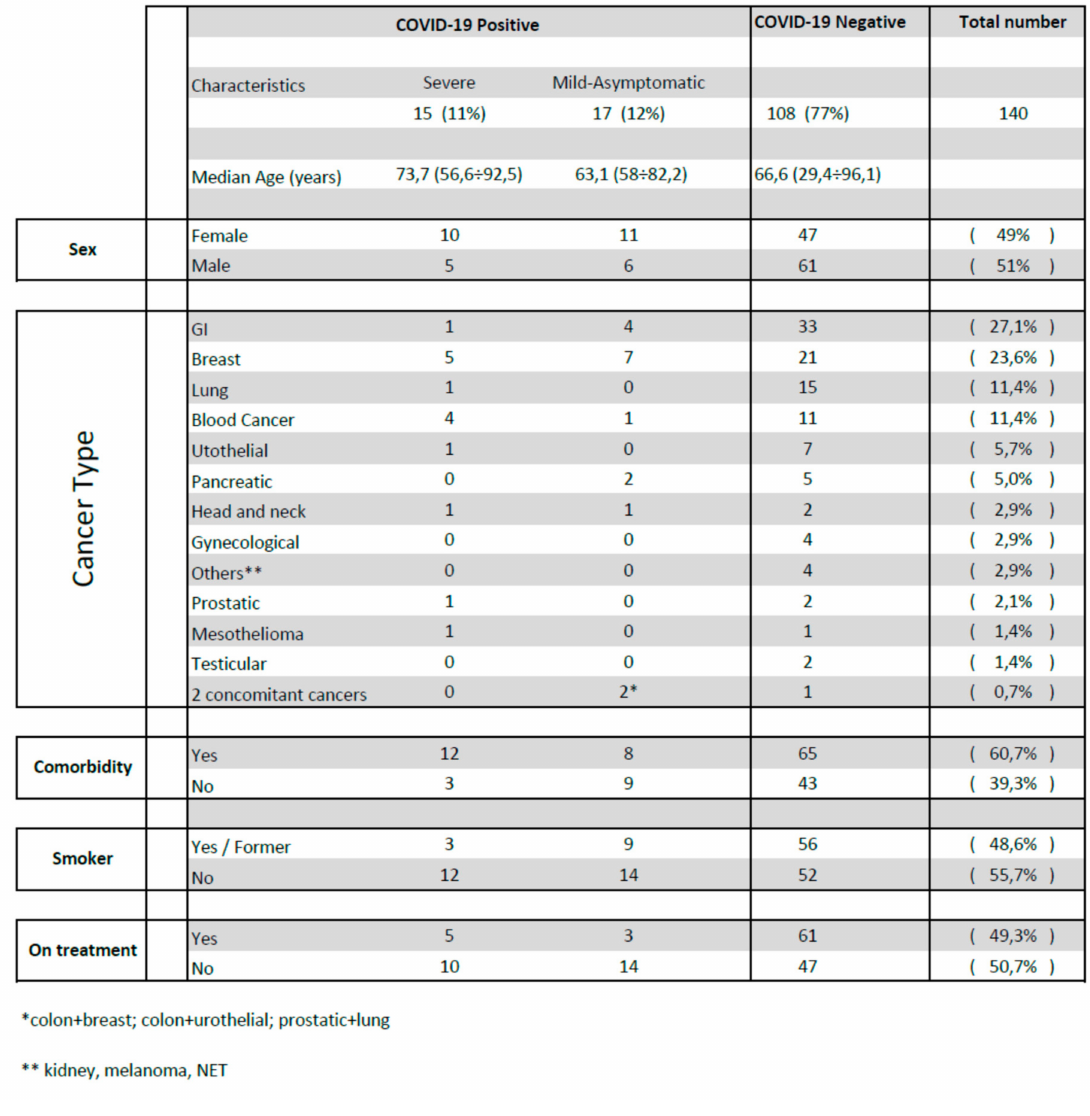
Figure 1. Clinical characteristics of cancer patients with severe, mild-asymptomatic COVID-19 infection and without